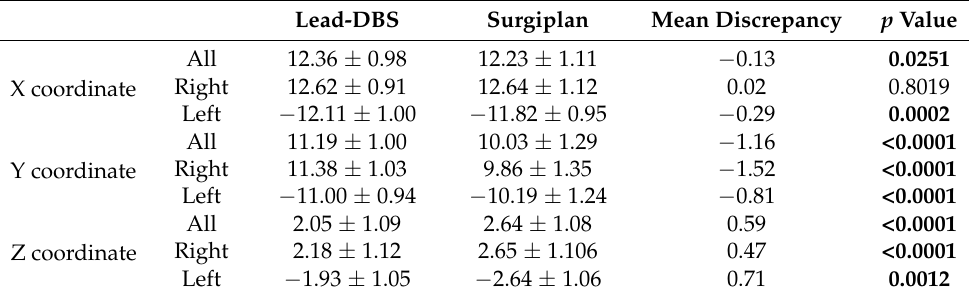
Figure 3. Coordinate distribution in the AC-PC system. The distributions of the coordinates from each patient with Lead-DBS and Surgiplan with postoperative CT are shown in the AC-PC system. The distributions of the left ( A ) and right ( E ) electrode contact coordinates are shown in 3D space. The left electrode coordinate distribution is also shown in left to right ( B ), posterior to anterior ( C ), and inferior to superior ( D ) directions. Similarly, the right electrode coordinate distribution is also shown in right to left ( F ), posterior to anterior ( G ), and inferior to superior ( H ) directions. Table 2. Coordinates calculated using Lead-DBS and Surgiplan with postoperative